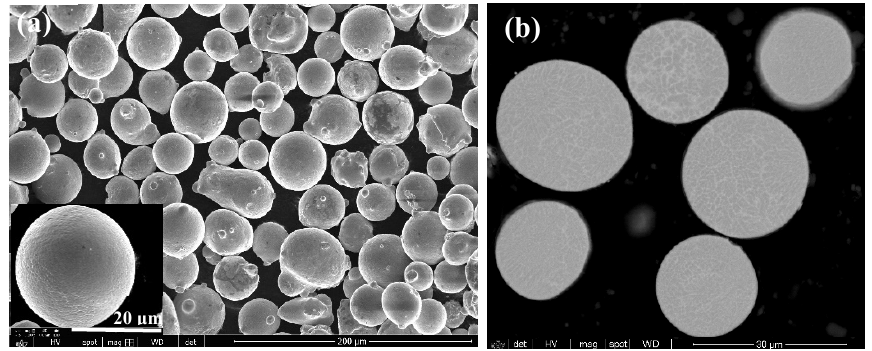
Figure 1. Surface morphology ( a ) and cross-section morphology ( b ) of NiCoCrAlYCe feedstocks. The inset in ( a ) is magnified image of surface morphology.